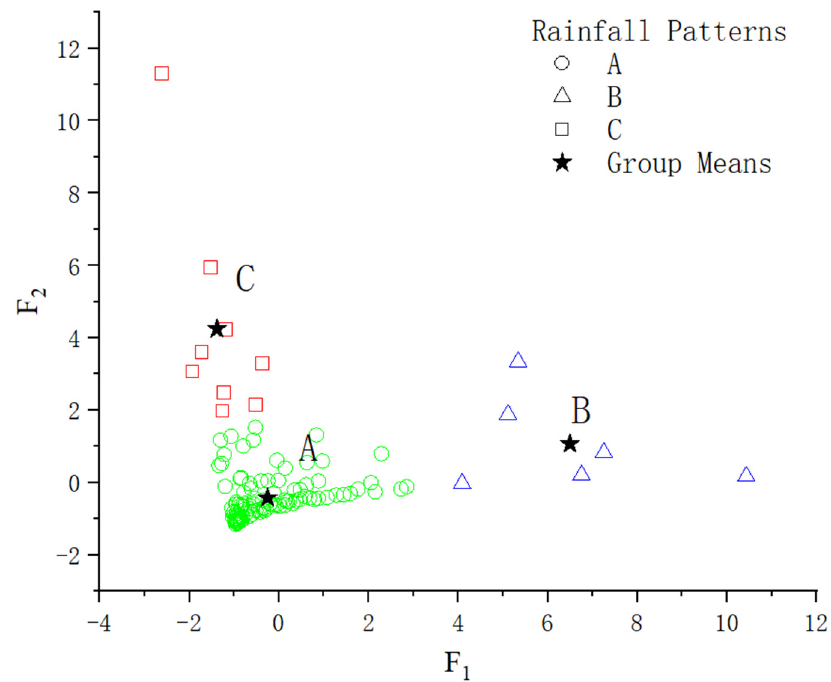
Figure 3. Scatterplot showing rainfall discrimination and classification analysis results.